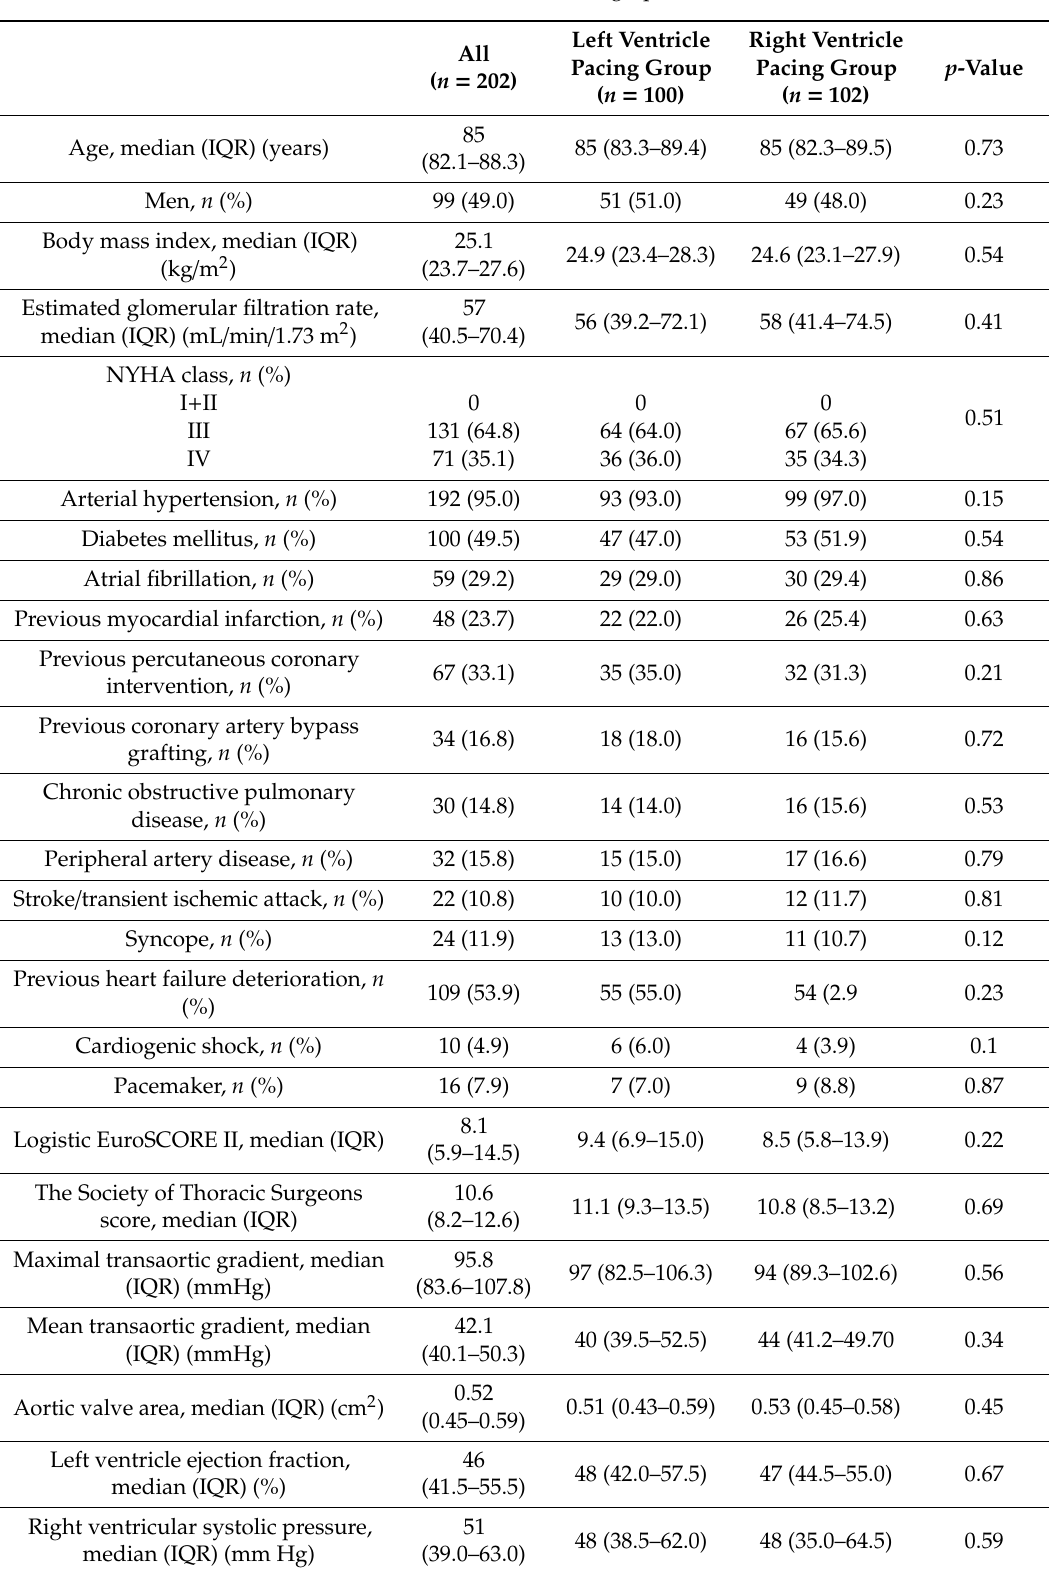
Table 1. Baseline clinical and echocardiographic